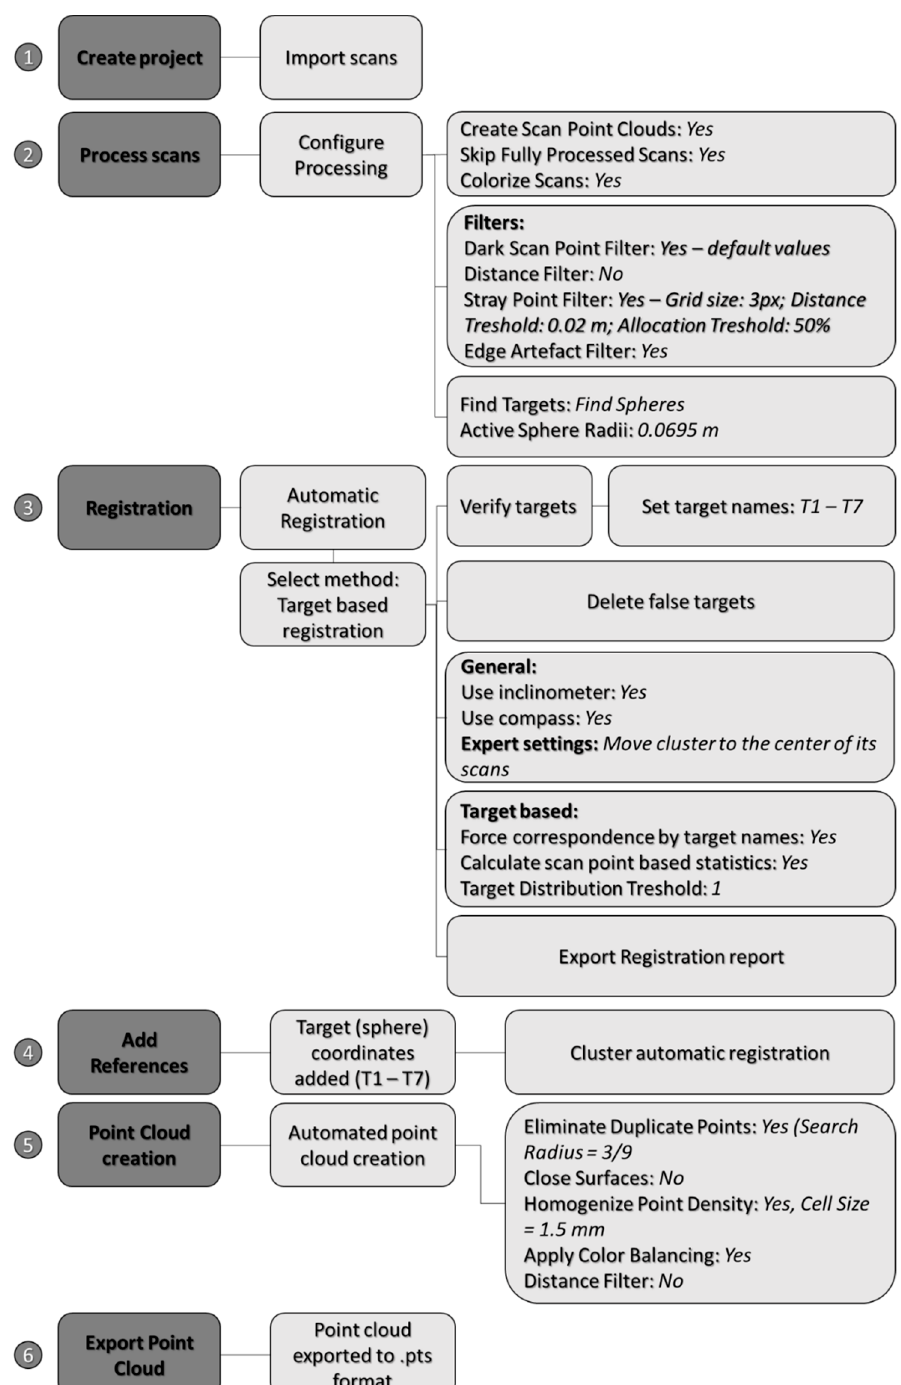
Figure 6. Methodology applied for processing of multi-temporal LiDAR data in Faro SCENE